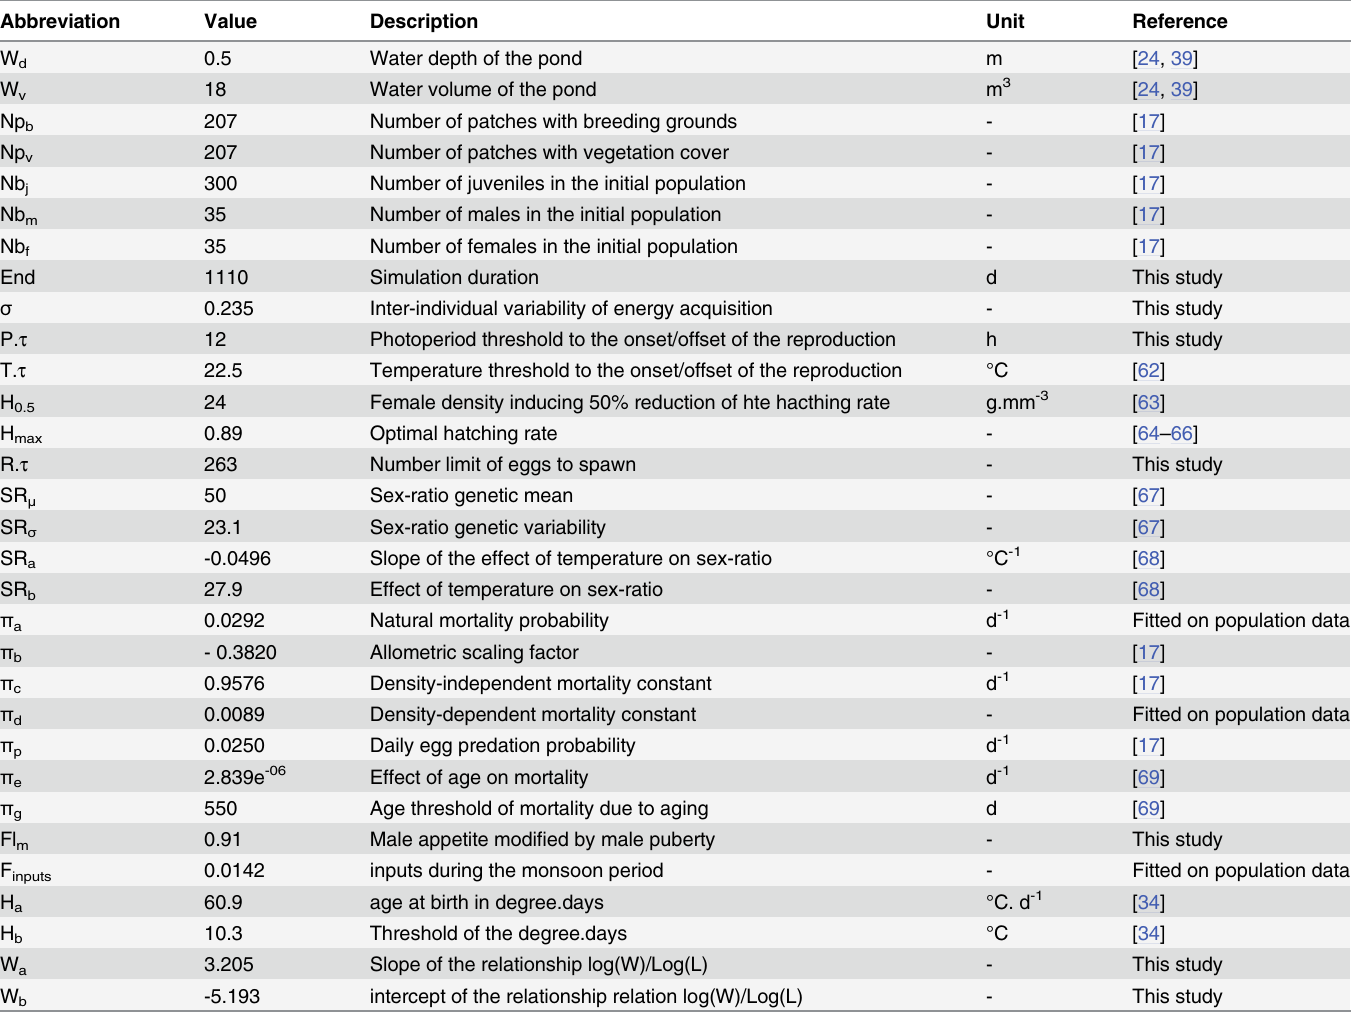
Table 3. Parameter abbreviations, values, descriptions and units of the